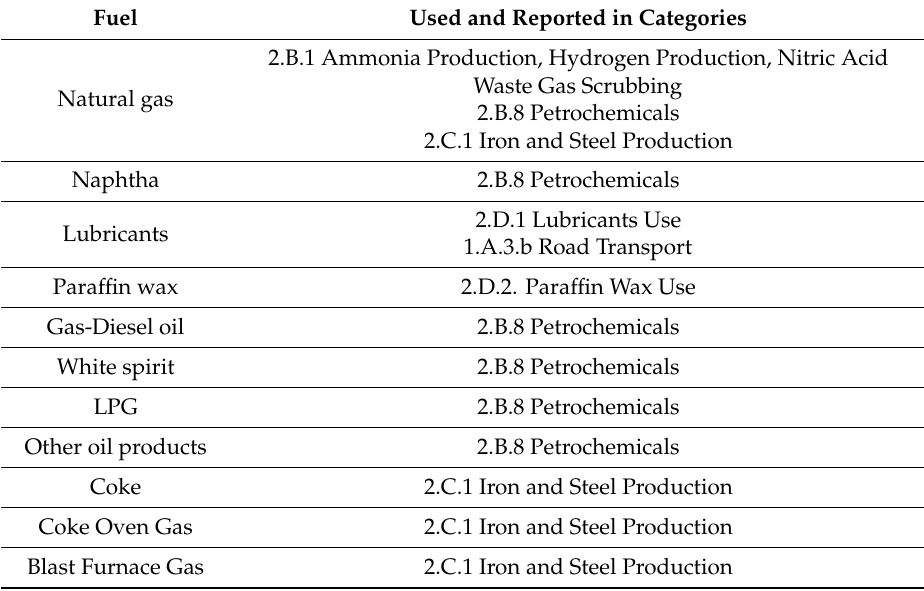
Table 5. The allocation of non-energy use of fuels in the IPPU sector in